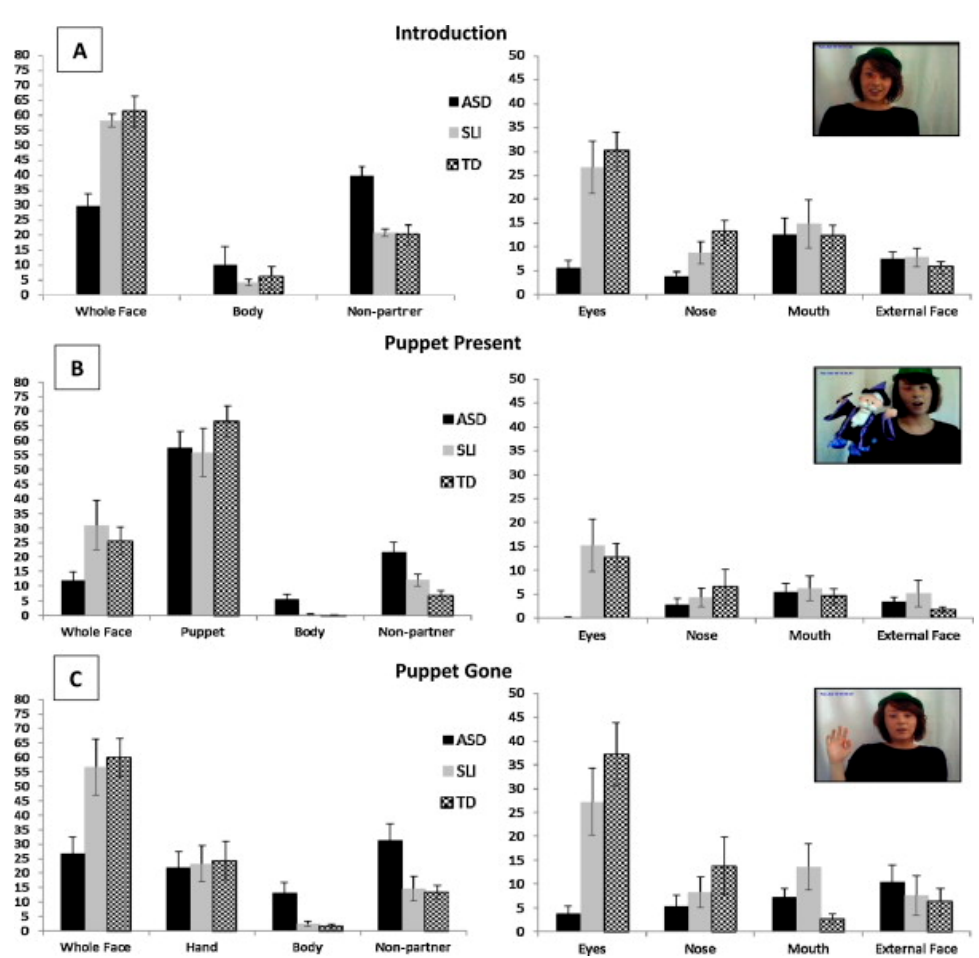
Figure 6. Percentage gaze to areas of interest for each section and for each group during a face-to-face interaction in Hanley et al.’s research [64]. Reproduced with permission from Elsevier.